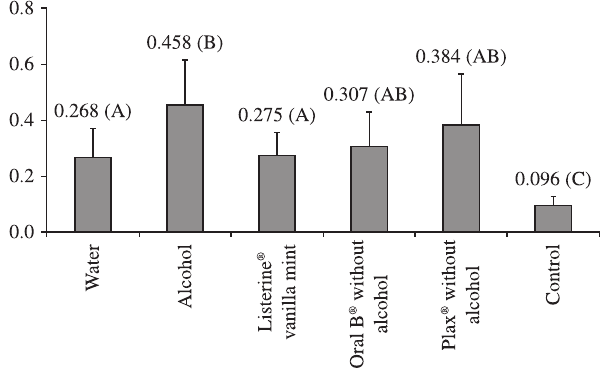
Figure 1. Results for roughness (mean values in μ m) according to the prod- ucts employed. *Different letters in parenthesis indicate statistical difference among the groups according to Tukey’s